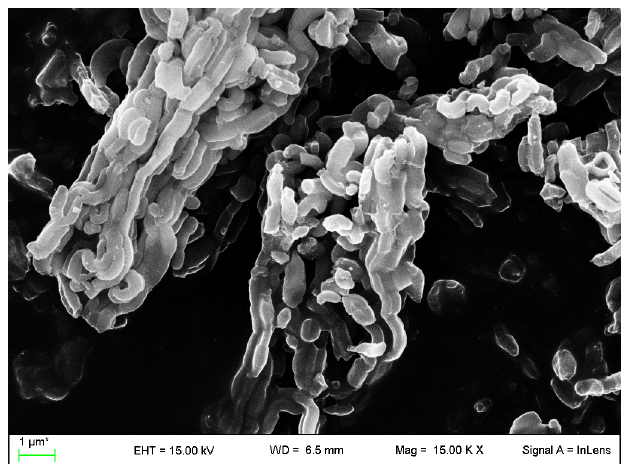
Figure 7. FE-SEM micrographs of VC-IP@SBA-15.